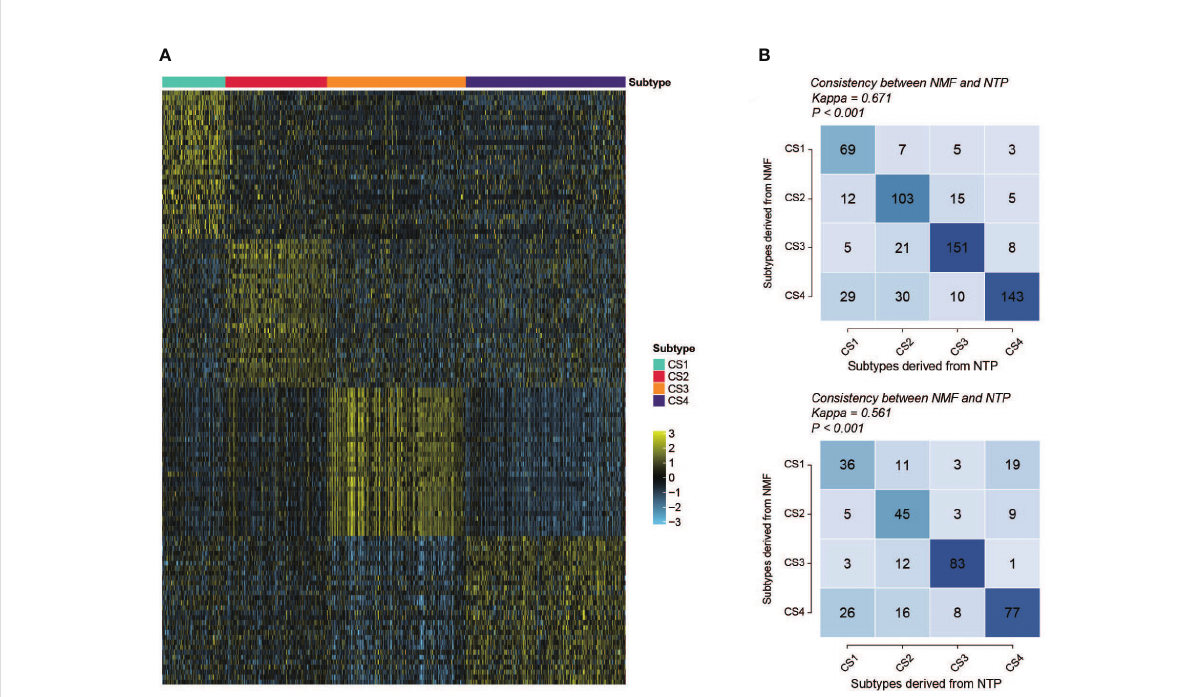
FIGURE 9 Performance and validation of the classi fi er. (A) Heatmap of the expression of the subclass classi fi er, 30 top up-regulated genes per subtype were illustrated. (B) Performance of the classi fi er (top, training set; bottom, validation set). Vertical axis shows the classi fi cation resulted from NMF; horizontal axis shows the classi fi cation predicted by